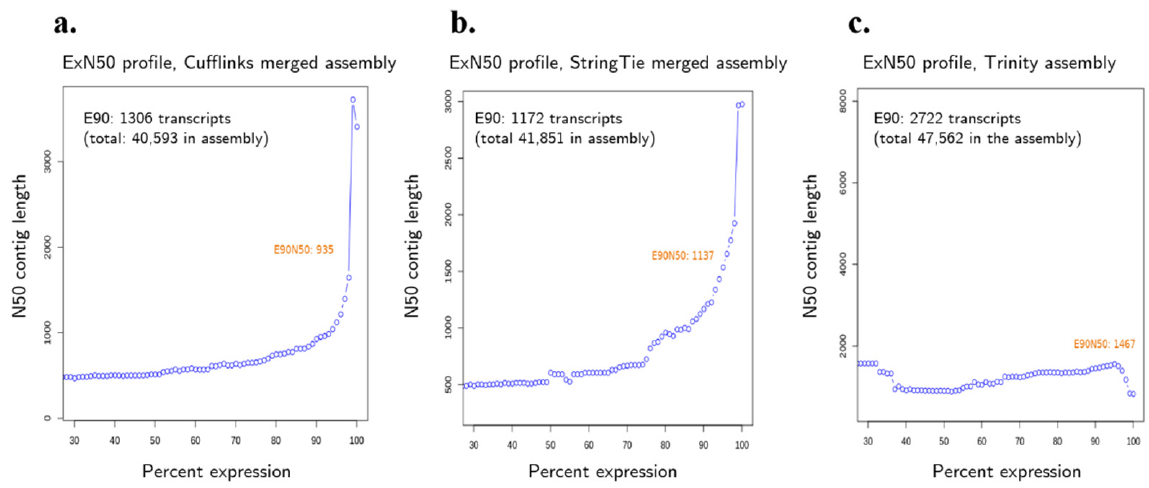
Figure 4. ExN50 profiles of the ( a ) Cufflinks, ( b ) StringTie, and ( c ) Trinity merged Bombyx mori transcriptome assemblies.